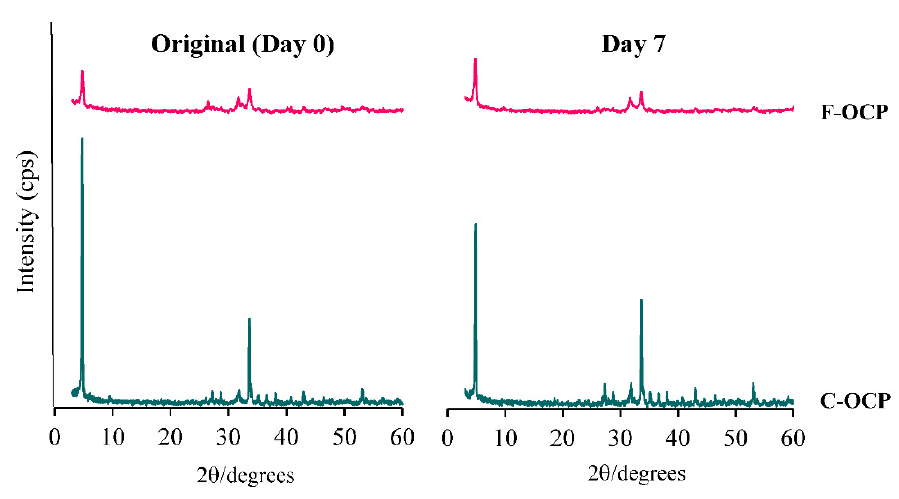
Figure 2. X-ray diffraction patterns of F-OCP and C-OCP at the original (day 0) and day 7 after immersion in Tris-HCl buffer. The Fourier transform infrared spectroscopy (FTIR) analysis showed that both F- OCP and C-OCP had five characteristic peaks of OCP (Figure 3). Two sharp adsorption bands originating from ν 4 PO 4 at approximately 560–600 cm − 1 were observed. Three dis- tinct bands of ν 3 PO 4 and ν 3 HPO 4 at 1020–1130 cm − 1 were attributed to the typical OCP structure. The splitting of the 1022 and 1038 cm − 1 and 1105 and 1121 cm − 1 bands of C-OCP indicate that C-OCP has higher crystallinity than F-OCP.